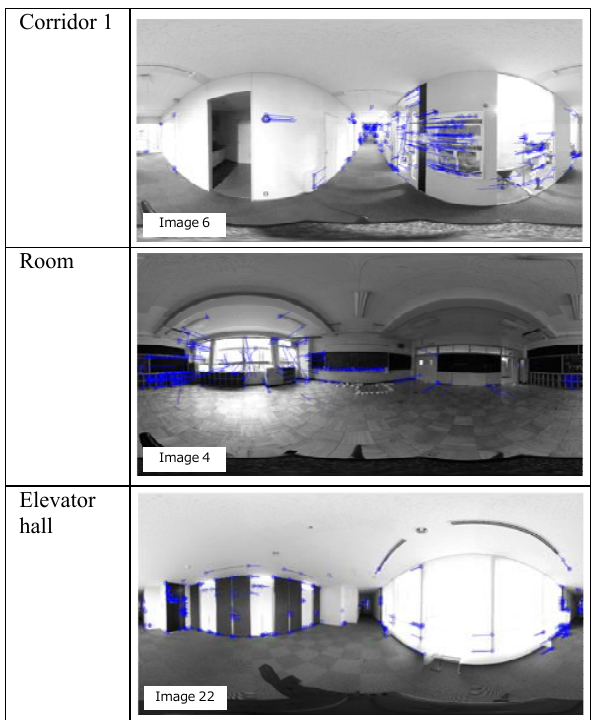
Figure 12. Estimated optical flows (Corridor 1, Room, and